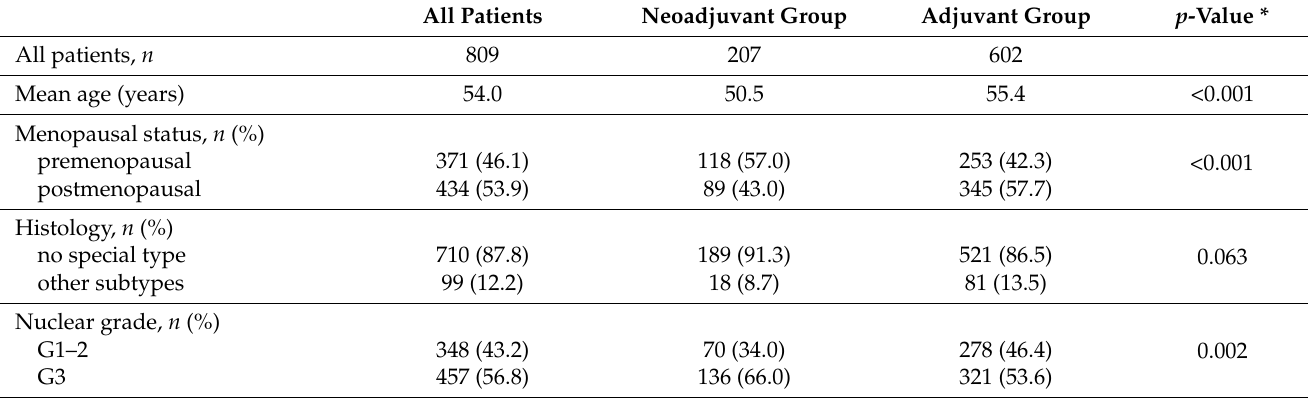
Table 1. Characteristics of patients that received neoadjuvant as compared to adjuvant